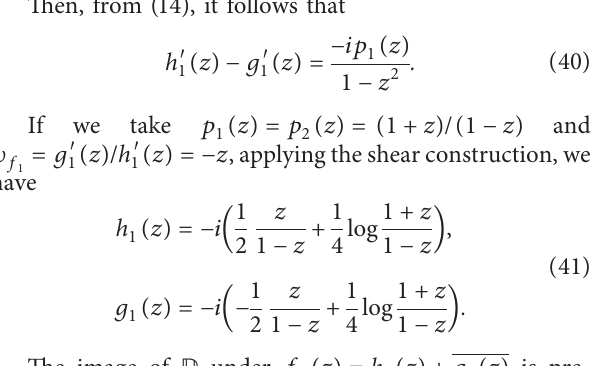
. (b) f . (c) f � (( 1 + i ) /2 ) f 1 2